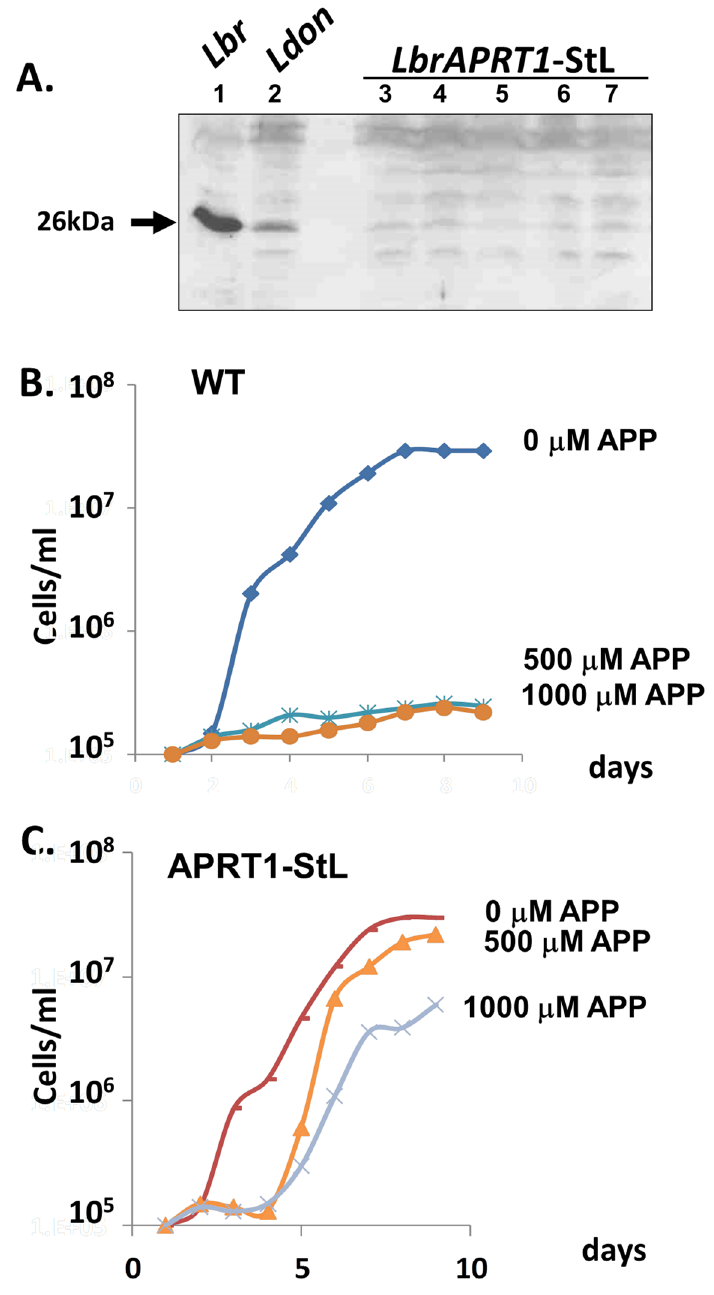
Figure 6. RNAi of the APRT1 gene yields increased APP resistance. ( A ) Transfection of APRT1 -StL leads to loss of APRT1 expression. The figure shows a Western blot of promastigotes tested against anti-APRT1 antisera. Lane 1. L. braziliensis WT; lane 2, L.donovani WT; lanes 3–7, Lbr APRT1 -StL clones 1 to 5. ( B , C ) Growth inhibition by APP in the indicated concentrations is shown. ( B ): WT Lbr ; ( C ): Lbr APRT1 -StL knockdown clone 1. The APRT1 -StL line is significantly more resistant to APP than WT at the concentrations shown (n = 4; p < 0.0001).